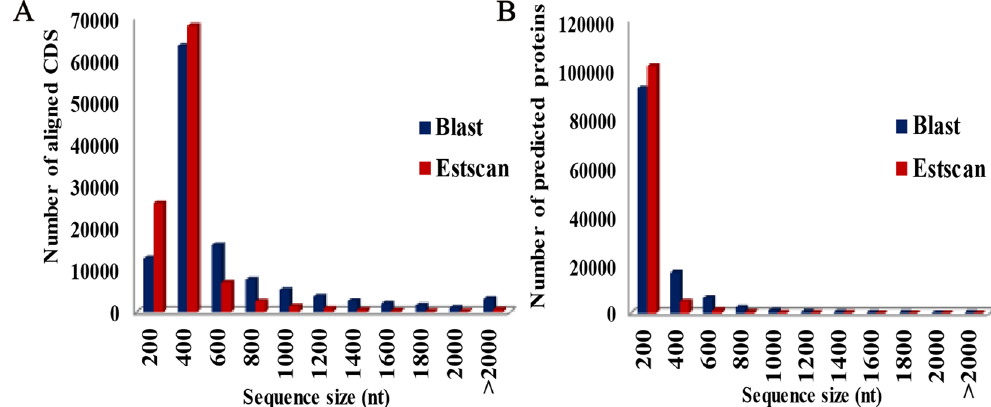
Figure 1. The length distribution of the coding sequence (CDS) and predicted proteins by BLASTx and Estcan software from the unigenes. Aligned CDS ( A ) and predicted proteins ( B ) by BLASTx and Estcan.